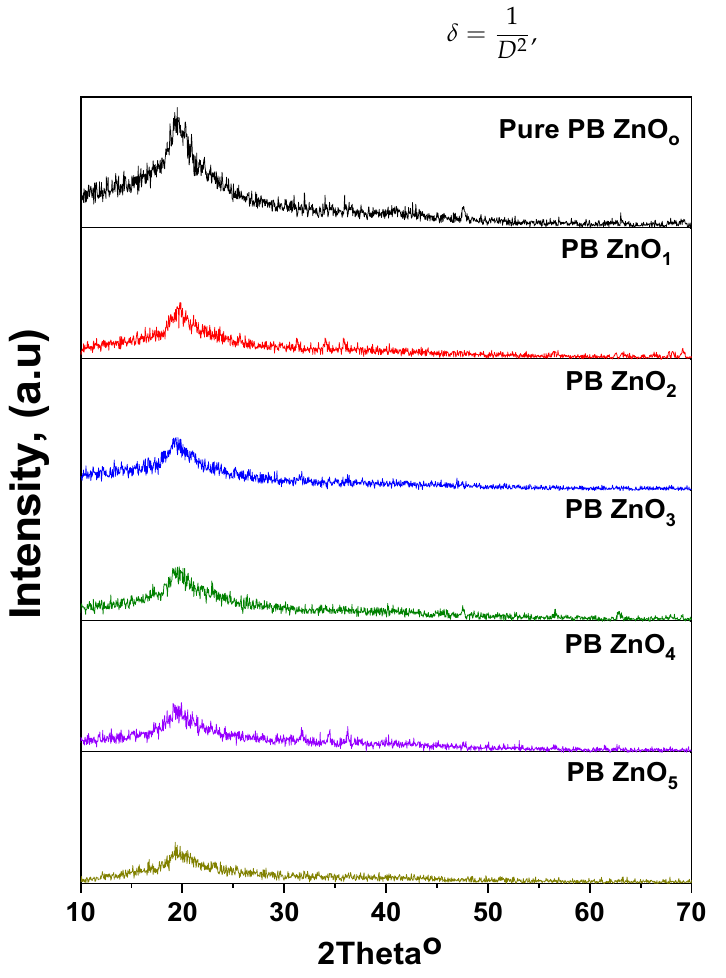
Figure 1. XRD spectra of PVA/PVP blend and ZnO polymeric nanocomposite films. Table 1. The calculated values of crystalline size ( D ), d -spacing, dislocation density ( 𝛿 ), and strain length ( 𝜀 ) of the PVA/PVP doped in ZnO nanocomposite films.